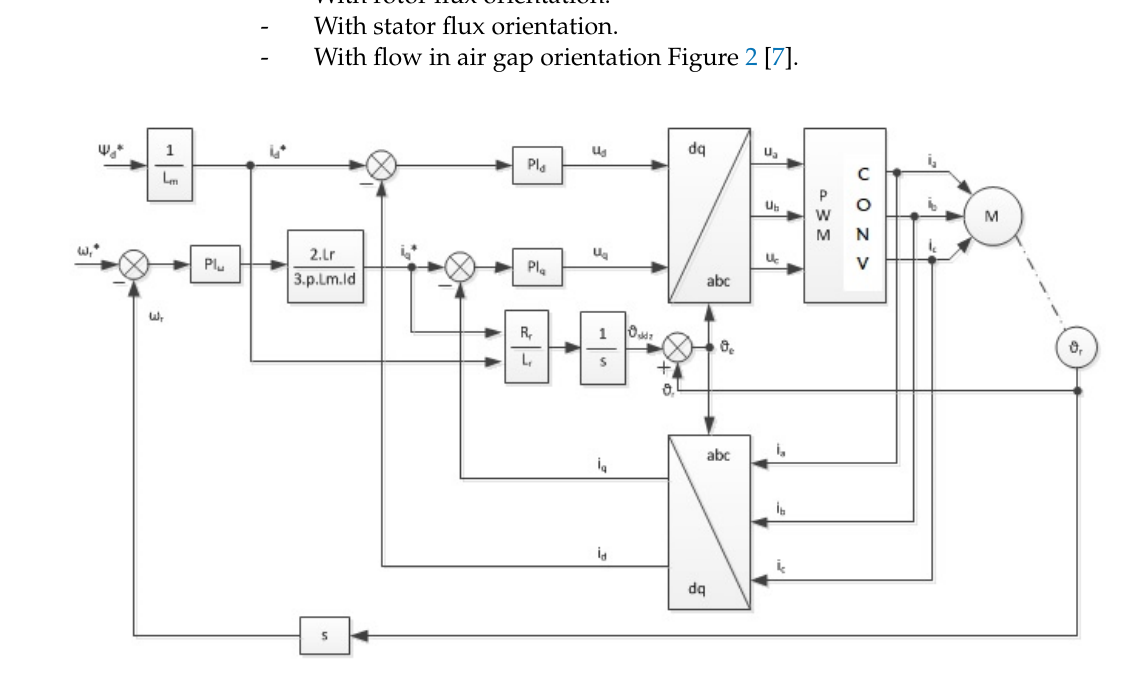
Figure 2. Block diagram of vector control with rotor flux orientation .